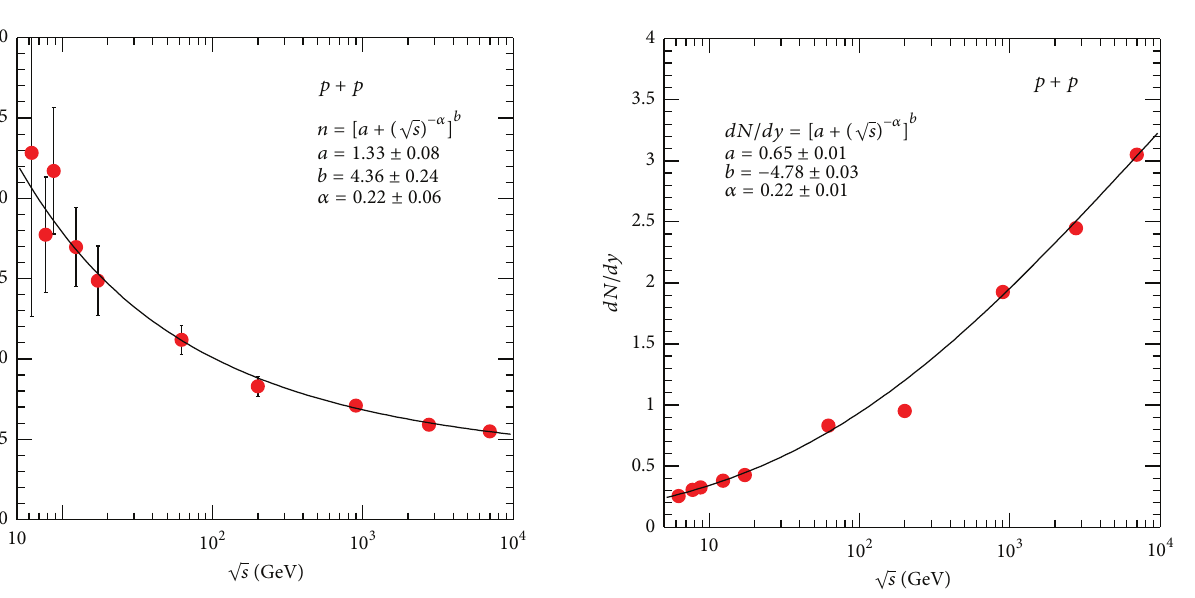
Figure 4: The variation of the integrated yield 𝑑𝑁/𝑑𝑦 for charged pions as a function of √𝑠 . The solid curve represents the parameter- 𝑏 ization (𝑎 + (√𝑠) −𝛼 ) .